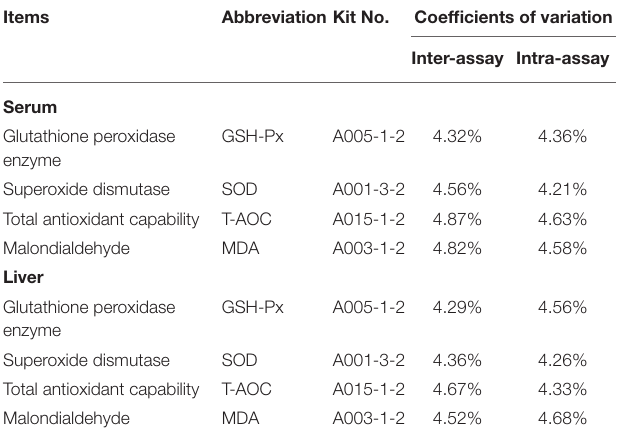
TABLE 3 | Primers used for real-time PCR. Genes Sequence (5 ′ -3 ′ ) Product